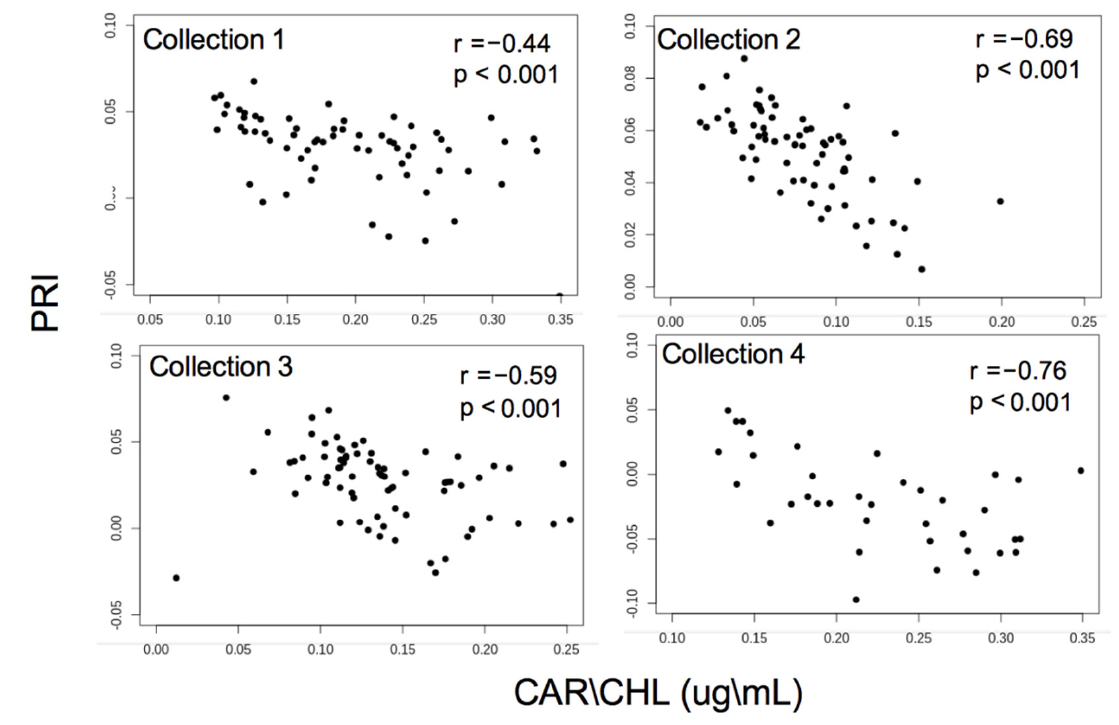
Figure 4. Correlation between photochemical reflectance index (PRI) and Car/Chl by collection, for 2017. See Table 2 for collection dates.